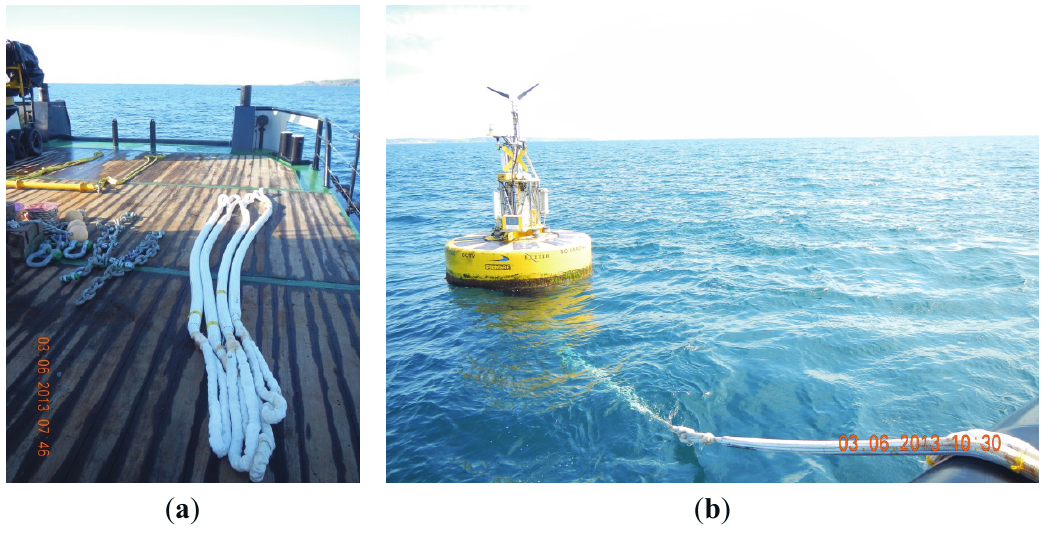
Figure 7. ( a ) Four tethers for deployment; ( b ) tethers being deployed at